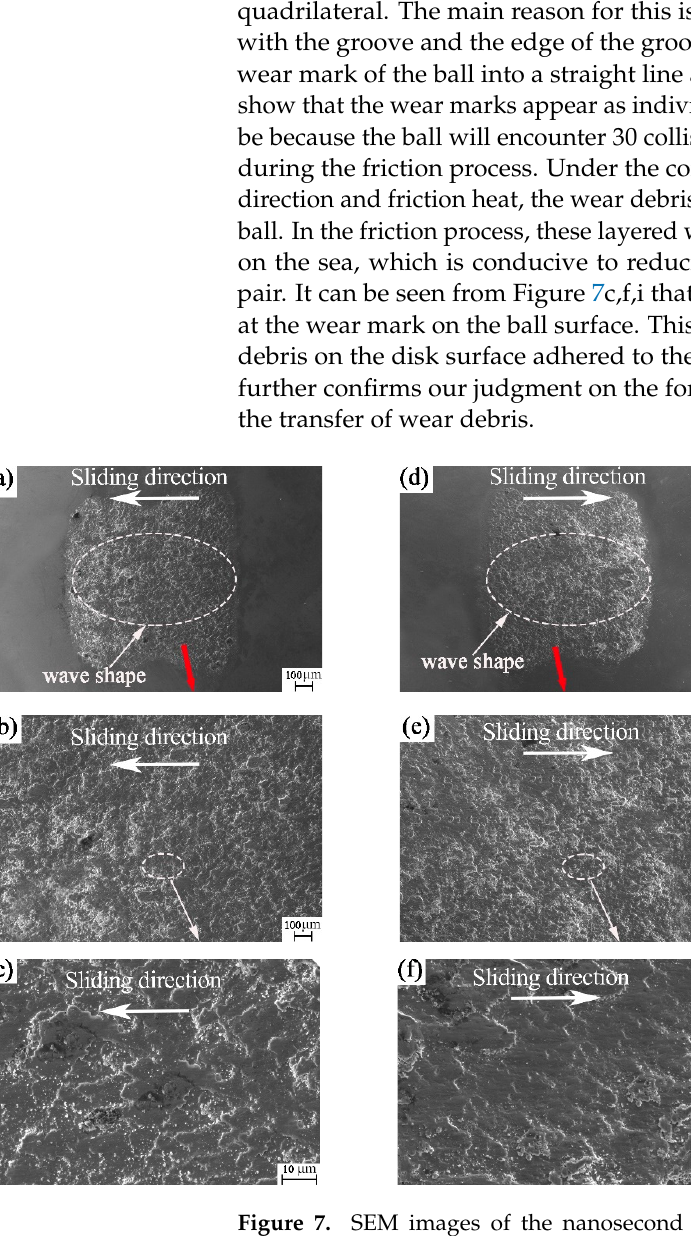
Figure 7. SEM images of the nanosecond textured worn balls: ( a – c ) rotation radius 15 mm; ( d – f ) rotation radius 18 mm; and ( g – i ) rotation radius 22.5 mm. ( d – f ) rotation radius 18 mm; and ( g – i ) rotation radius 22.5